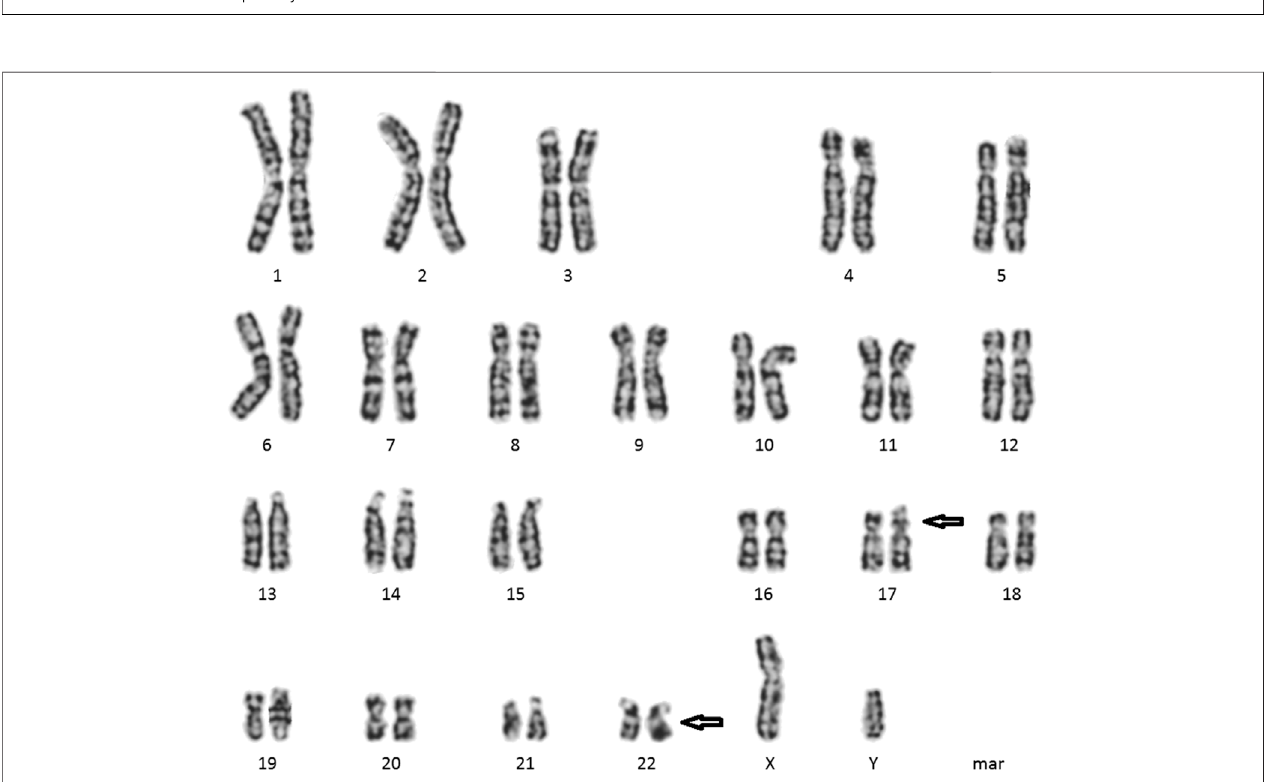
FIGURE 2 | Cytogenetic images of chromosome karyotype (from peripheral blood sample): 46, XY, t (17; 22) (p11.2; q11.2).